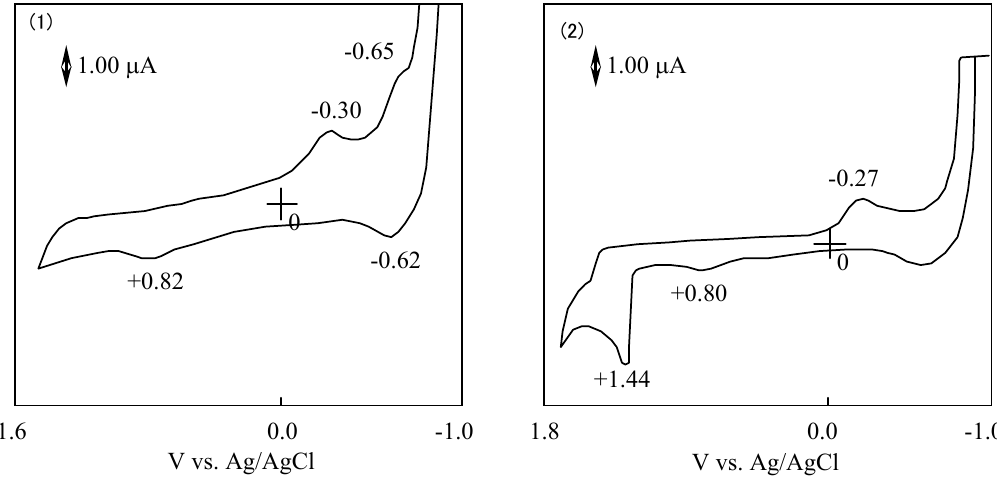
Figure 13. Cyclic voltammograms of subphthalocyanine derivatives in acetonitrile with tetrabutylammonium perchlorate. (1) Subphthalocyanine 6a . (2) hexakis( S -phenyl)hexa- fluorosubphthalocyanine 6d